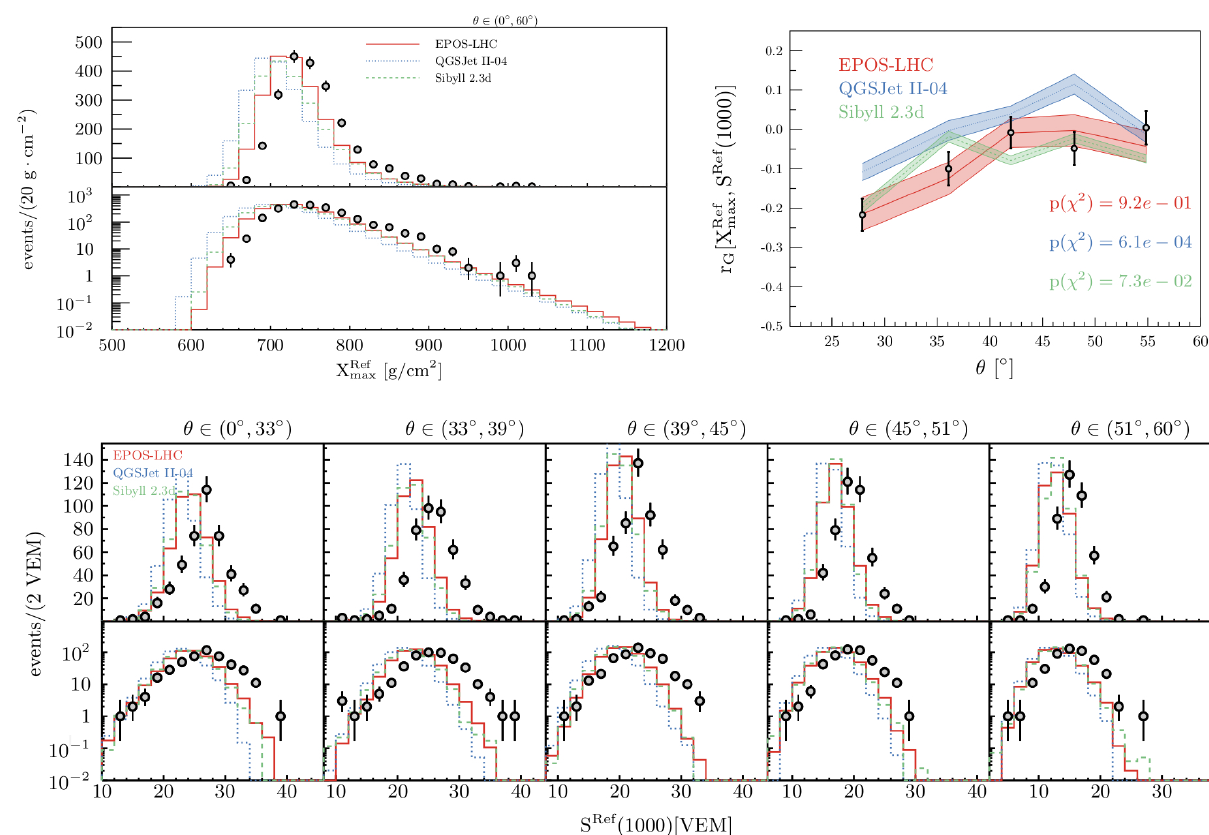
Figure 4: Description of data (black) by the composition fits without any modification of the MC templates. The pro- jected X max distribution (top left), projected S (1000) distributions for all five zenith-angle ( θ ) ranges and the zenith-angle dependence of the correlation between X max and S (1000) are shown for the three models of hadronic interactions (lines).